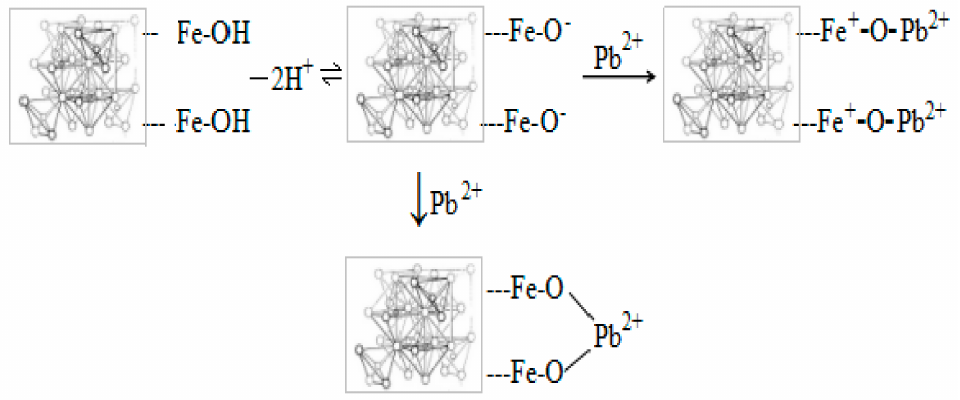
Figure 1. The adsorption mechanism of lead on magnetite nanoparticles